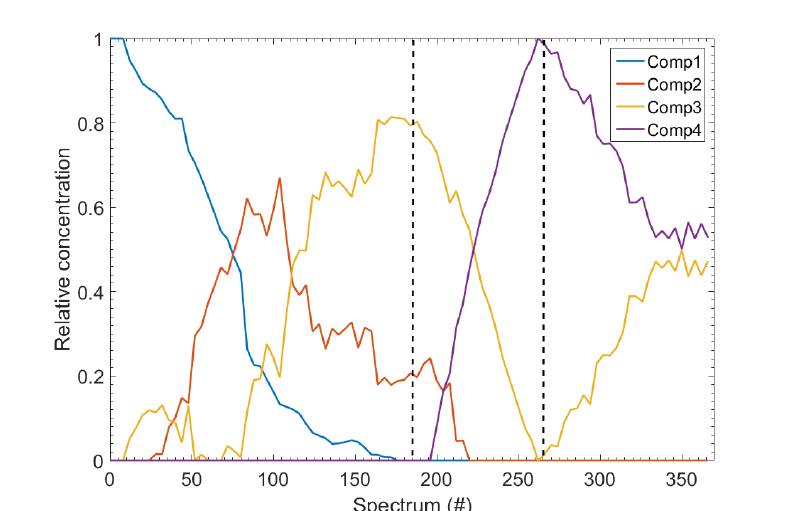
Figure 2. Concentration profile of pure spectral components obtained through MCR-ALS during 1.5 electrochemical cycles of TiO 2 vs. Na. The dashed lines indicate end of first discharge (#184) and end of first charge